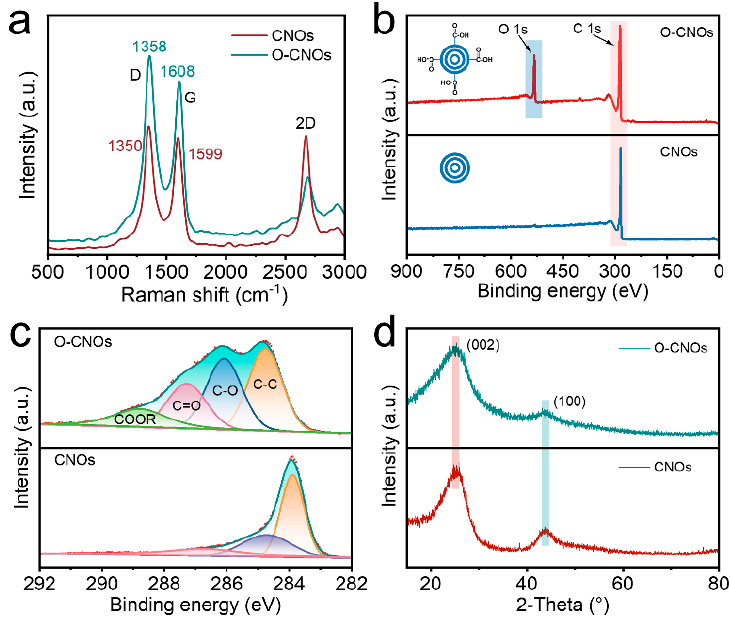
Figure 2. ( a ) Raman spectra of CNOs and O-CNOs obtained at oxidation time of 0.5 h. XPS analysis of all tested samples ( b ) and peak fitting of C 1s at high resolution ( c ). ( d ) XRD spectra of CNOs and O-CNOs.